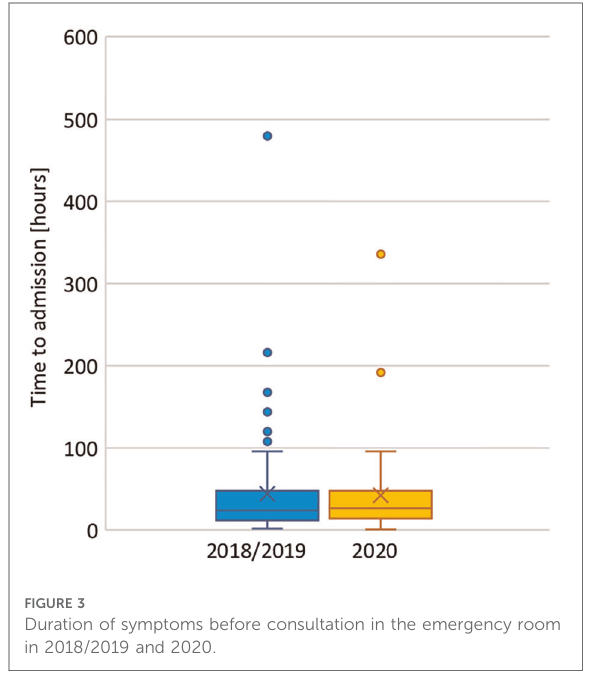
FIGURE 3 Duration of symptoms before consultation in the emergency room in 2018/2019 and 2020.